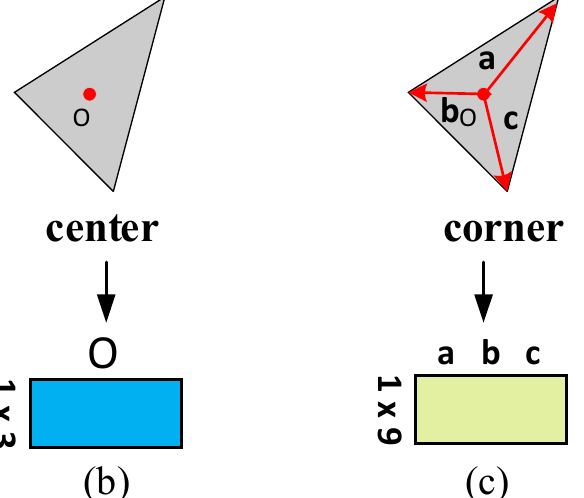
of the face; and ( c ) the vector from the center point to each of the three vertices. a , b , and c denote the